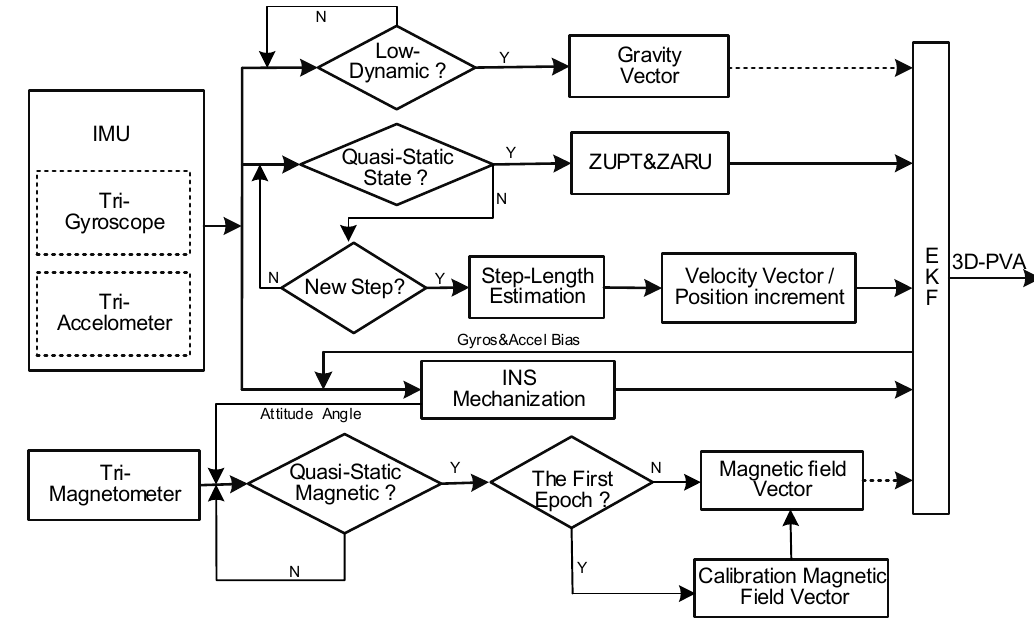
Figure 1. Detailed C ‐ INS solution process.